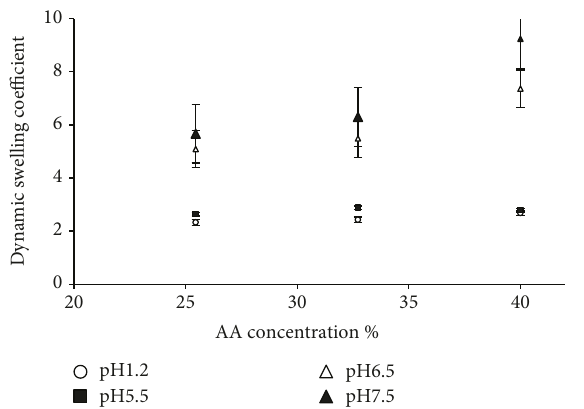
Figure 2: Dynamic swelling coe ffi cient of Poly (CMCS- g -AA) hydrogels with di ff erent concentration of AA (25.45, 32.72, and 40g) using EGDMA as crosslinking agent (0.7% of AA) in 0.05M USP phosphate bu ff er solutions of di ff erent pH at 37 ° C.